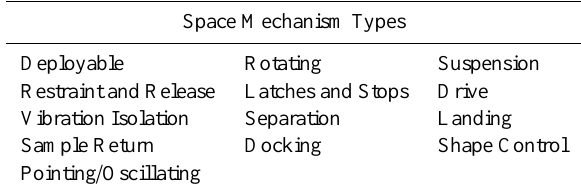
Figure 3. Example of a current space mechanism. Phoenix Mars Lander sample collection shovel. Courtesy of NASA / JPL-CalTech- University of Arizona. Table 3. Space Mechanism